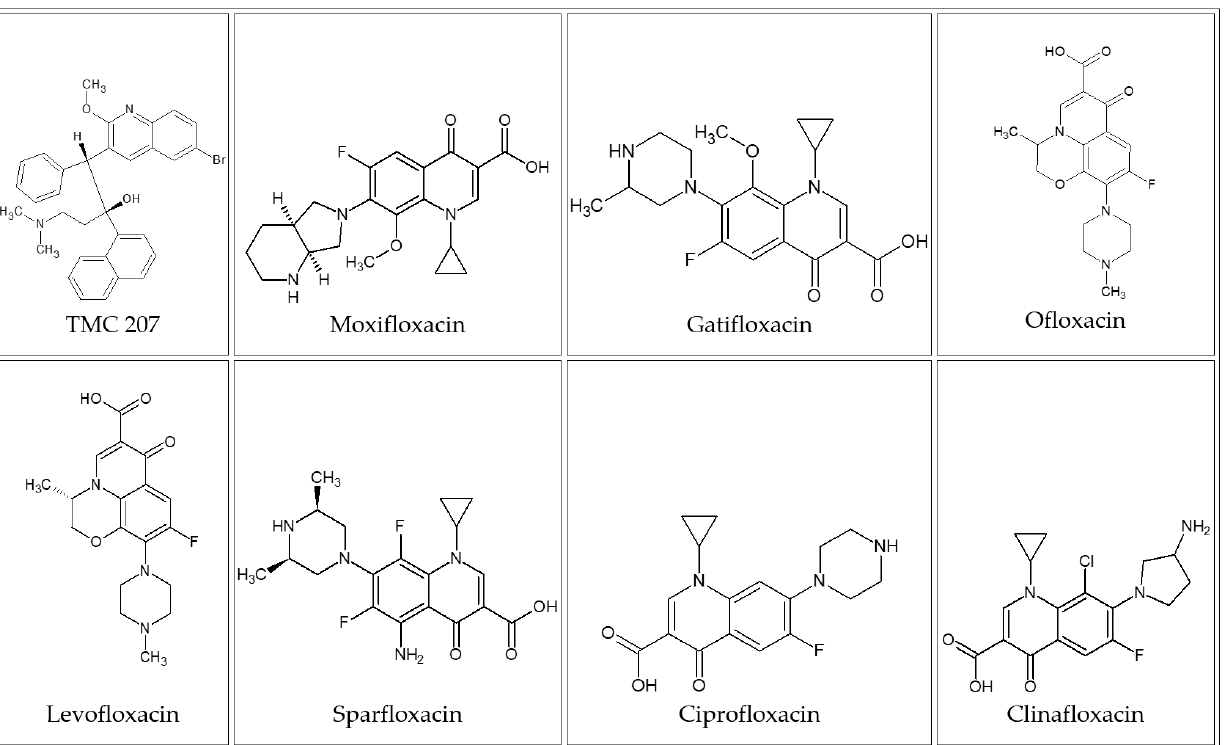
Figure 1. Chemical structures of bedaquiline and different typical antituberculosis quinoline com- pounds.